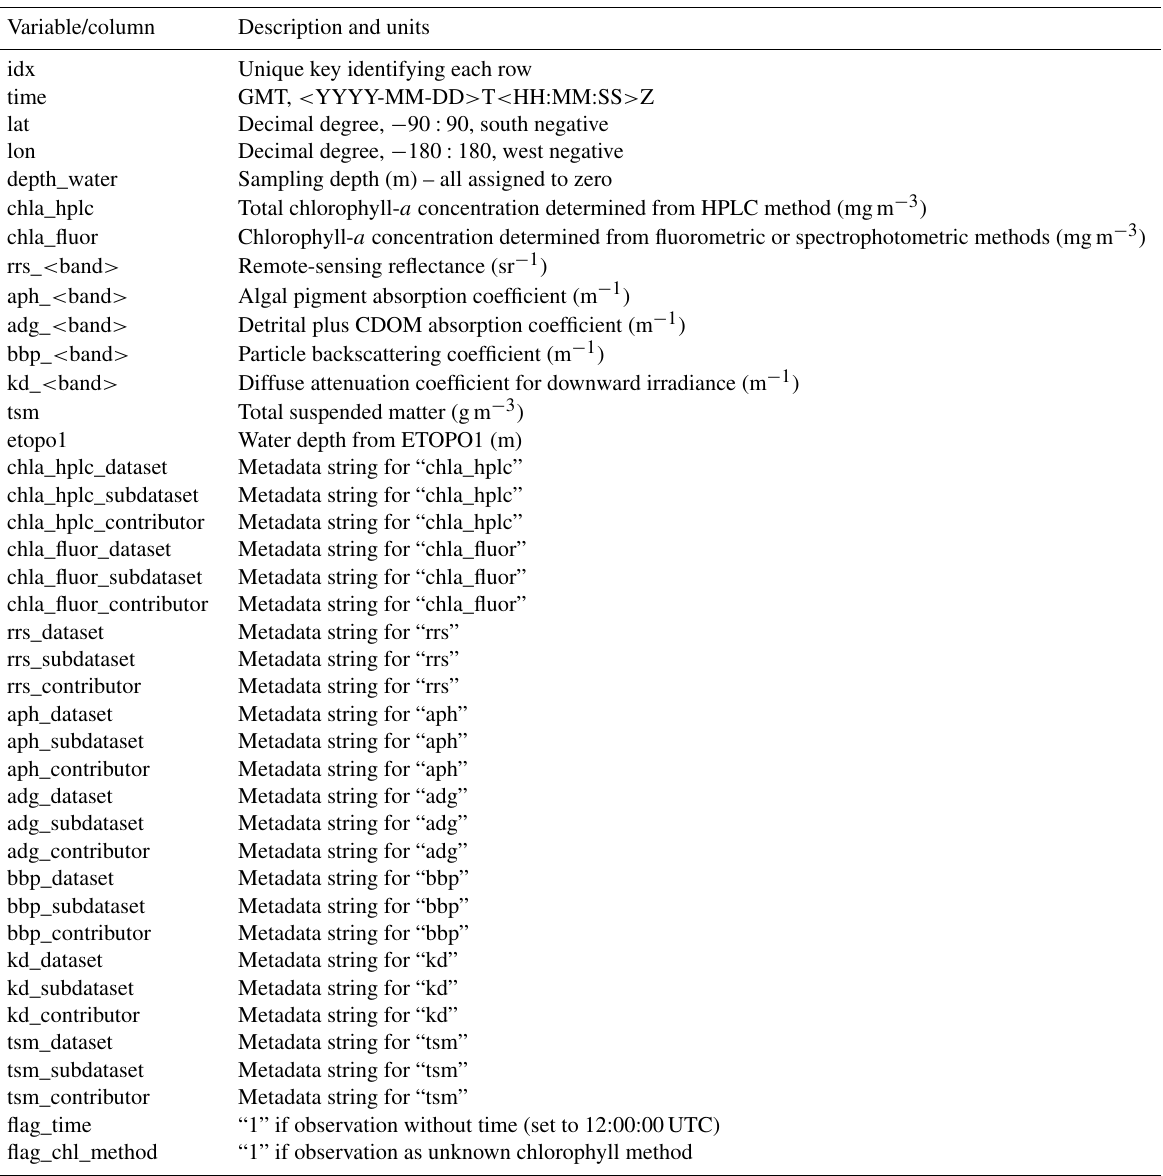
Table 1. The standard variables, nomenclatures, and units in the final table. Variable/column Description and